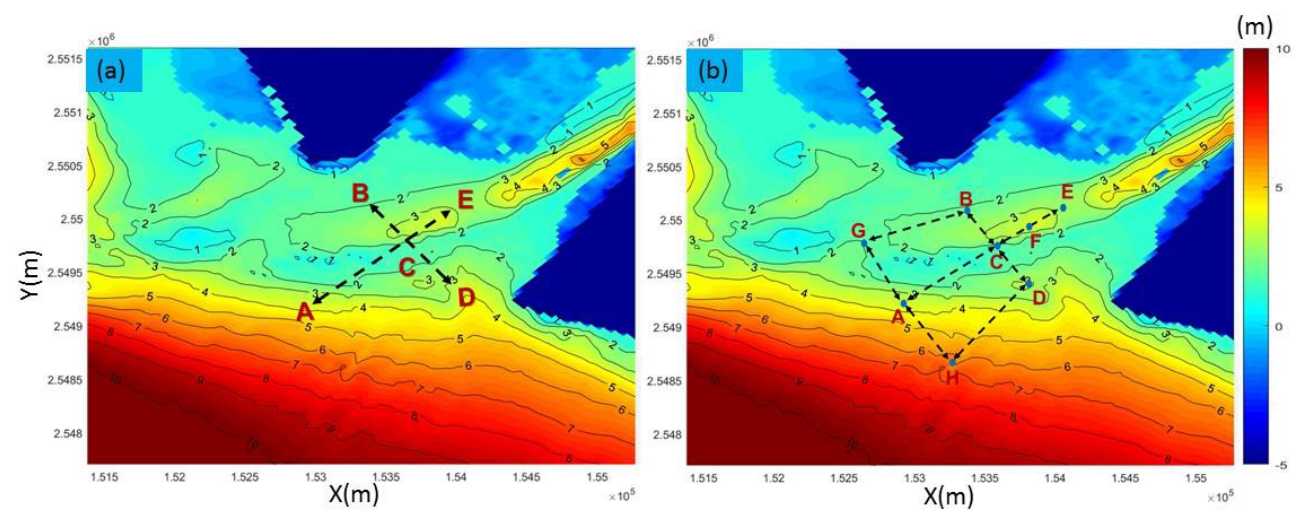
Figure 2. An expanded view of the river mouth bathymetry (color contours: depth, scale on the right) with co-located wave gauges, current meters (ADCP), and turbidity meters (Lisst 100X) during ( a ) 21–30 November 2018 and ( b ) 23 August–4 September 2019.